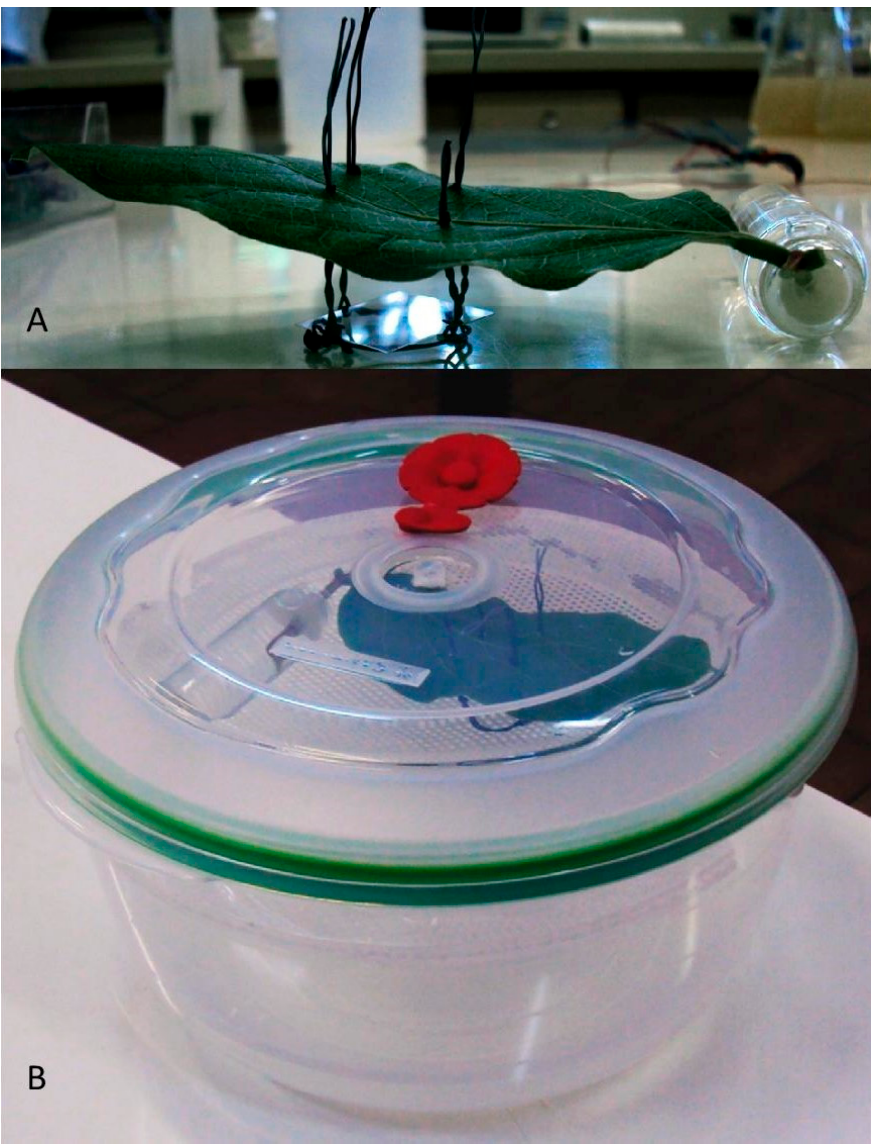
Figure 1. Detached Jack bean leaf assay setup ( A ) The experimental unit: Detached leaf placed above a photo-etched cover slip (18 × 18 mm) with alphanumeric coded squares for collection and counting of conidia discharged from sporulating Neozygites floridana killed Tetranychus urticae cadavers placed on the underside of the leaf ( B ) The experimental unit placed inside a plastic chamber (22.9 × 21.3 × 12 cm) providing controlled microclimatic conditions.